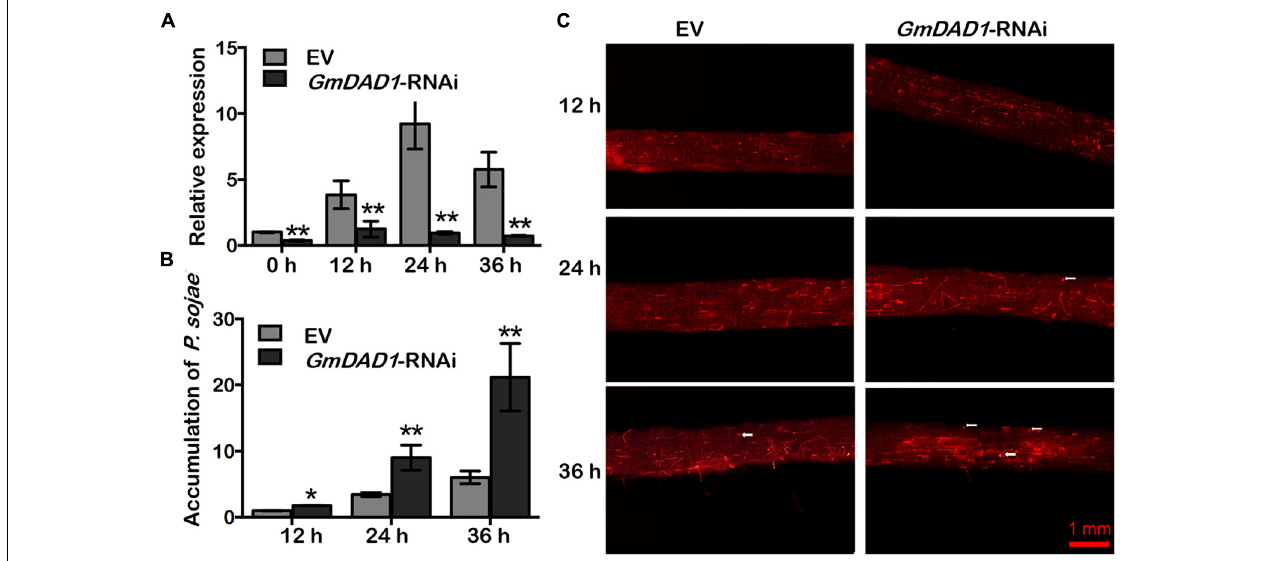
FIGURE 4 | Silencing of GmDAD1 reduces resistance to P. sojae in soybean hairy roots. (A) Relative expression of GmDAD1 was determined by RT-qPCR in inoculated hairy roots in which GmDAD1 was silenced via RNAi ( GmDAD1 -RNAi) or empty vector (EV) at 0, 12, 24, and 36 hpi. (B) Relative biomass of P. sojae was determined in inoculated hairy roots GmDAD1 -RNAi or EV at 12, 24, and 36 hpi. Values represent the means of three replicates ± SD. Data were analyzed by using Student’s t -tests ( ∗ P < 0.05, ∗∗ P < 0.01 compared with the control). (C) Microscopic analysis of P. sojae colonization in soybean hairy roots. The control EV and GmDAD1 -RNAi hairy roots were inoculated with zoospore suspension (10 4 zoospore/ml) of the P. sojae P6497-RFP. Photos were taken at 12, 24, 36 hpi. The white arrows indicate germinating oospores.